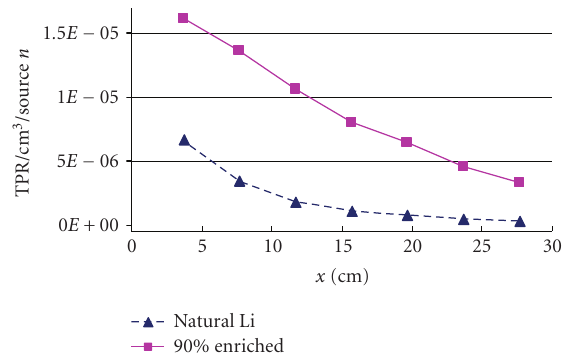
Table 2: Contribution of the uncollided flux.